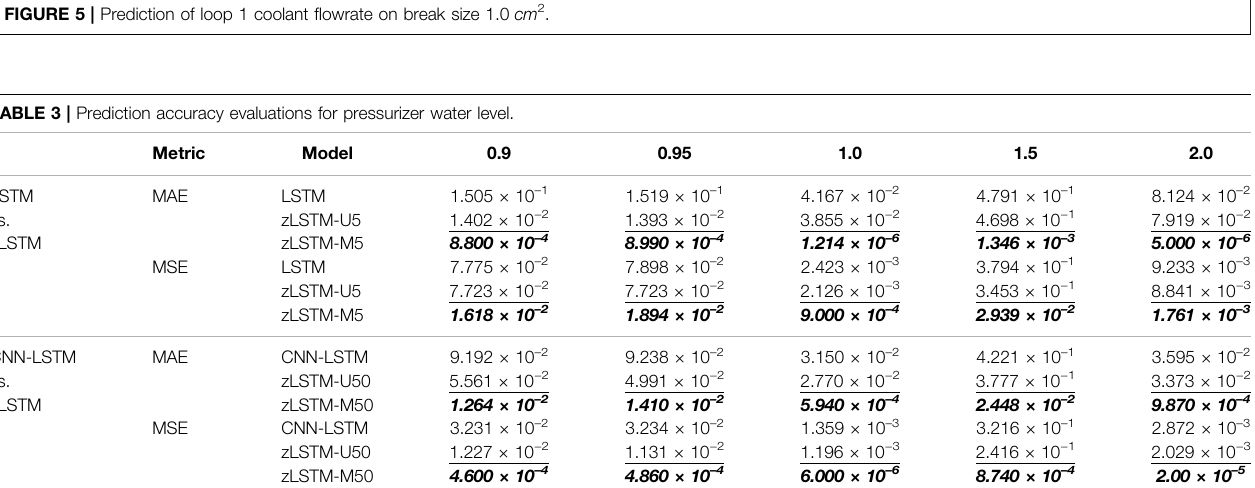
FIGURE 5 | Prediction of loop 1 coolant fl owrate on break size 1.0 cm 2 .